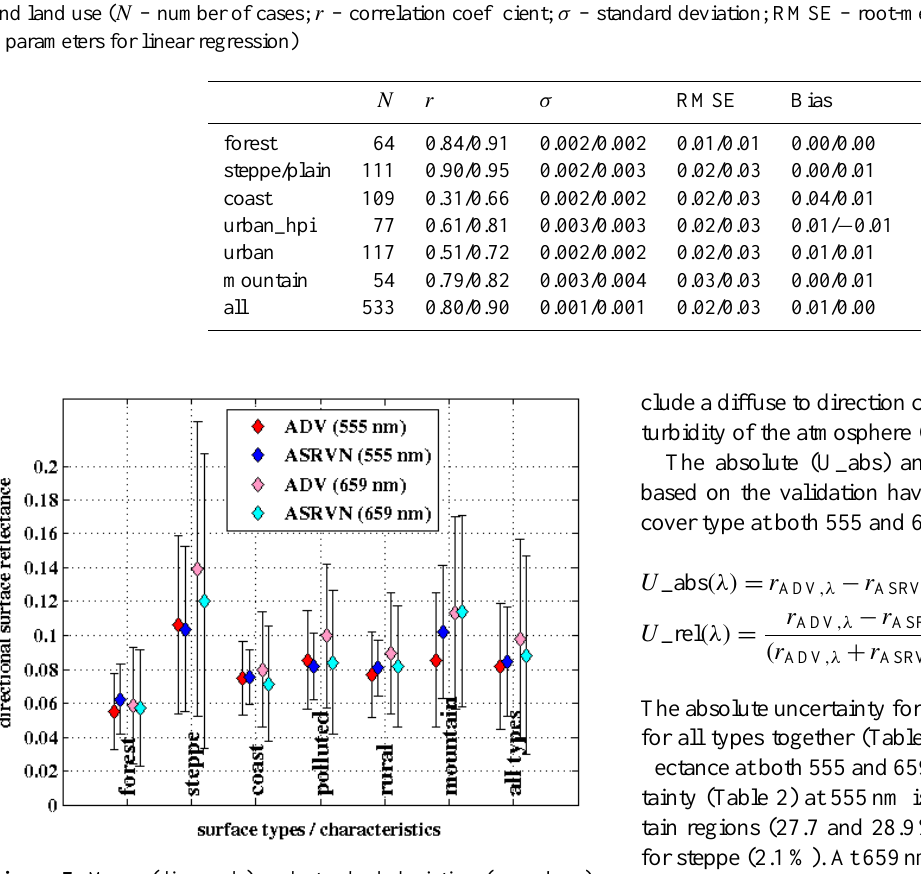
Figure 7. Mean (diamonds) and standard deviation (error bars) ADV surface reflectance (red, pink) and matched to the AATSR so- lar zenith (SZ) angles (blue, turquoise) for wavelengths of 555nm (red, blue) and 659nm (pink, turquoise), averaged for different sur- face